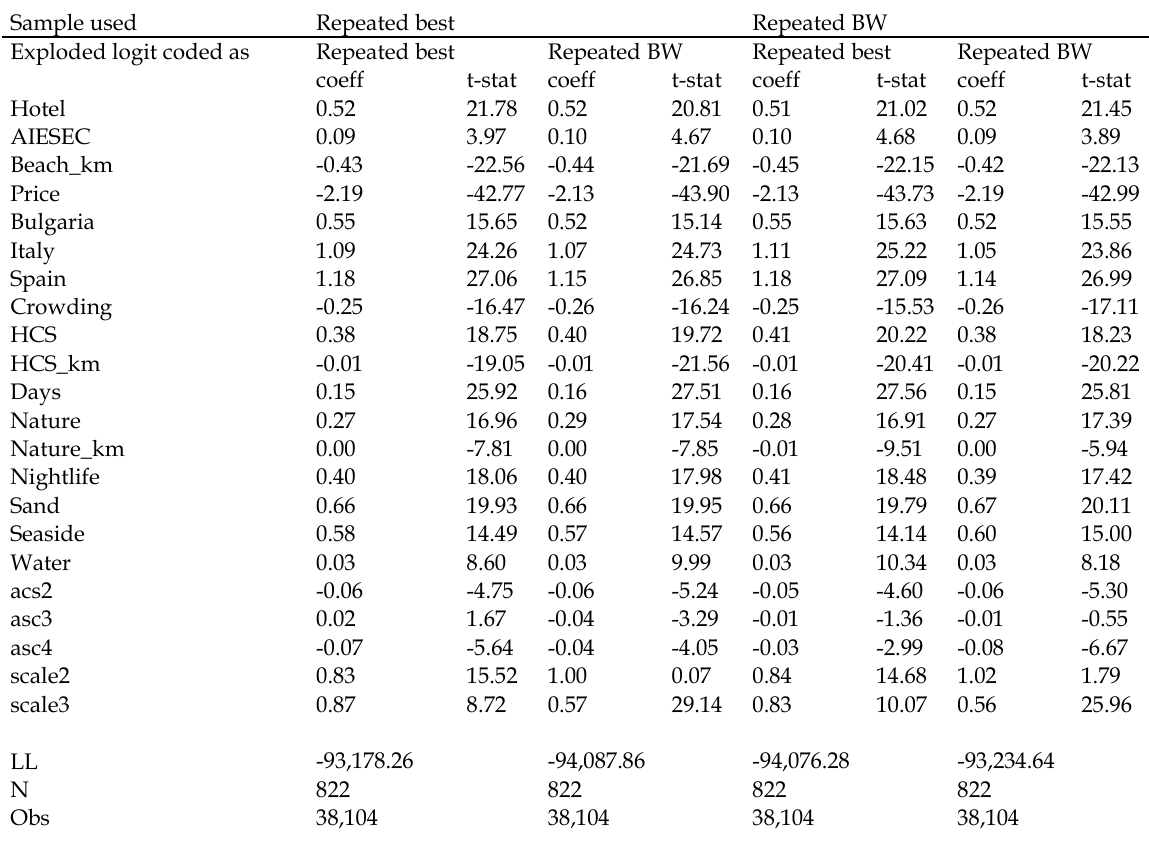
Table 6. Model estimates for model specification II before and after